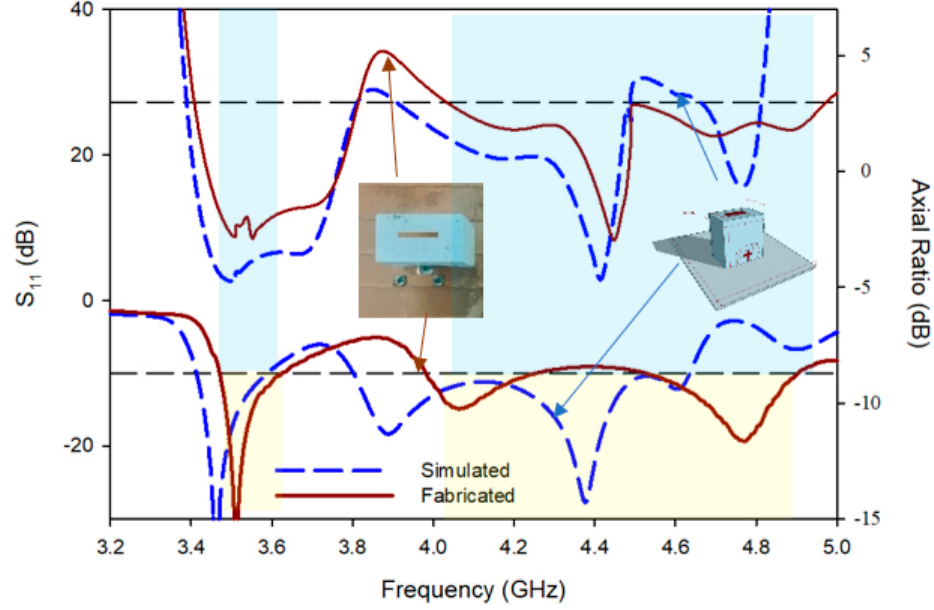
Figure 10. Simulated and Fabricated results of S 11 and the axial ratio of proposed RDRA.